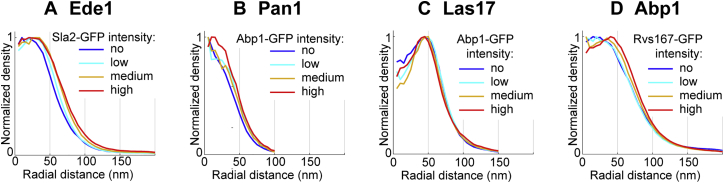
Average Radial Profiles of Ede1, Pan1, Las17, and Abp1 Staged Using Diffraction-Limited Timing Markers, Related to Figures 3 and 5Average radial profiles of (A) Ede1-mMaple staged by Sla2-GFP, (B) Pan1-mMaple staged by Abp1-GFP, (C) Las17 staged by Abp1-GFP, (D) Abp1 staged by Rvs167-GFP.